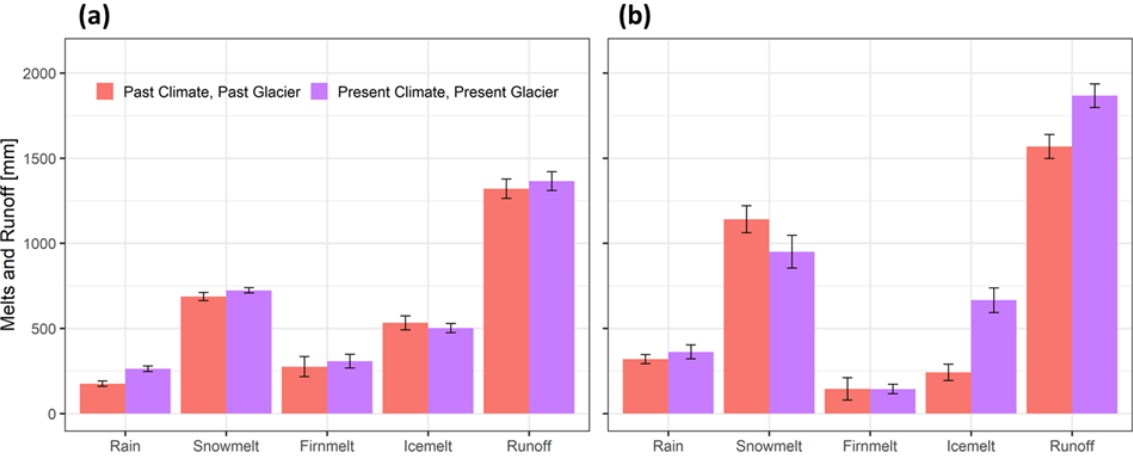
Figure 7. Mean annual melt, rainfall–runoff, and basin runoff for the past and present glacier configuration and climate scenarios. Error bars show the annual variability, which is defined as the standard error between years. (a) AGRB. (b)